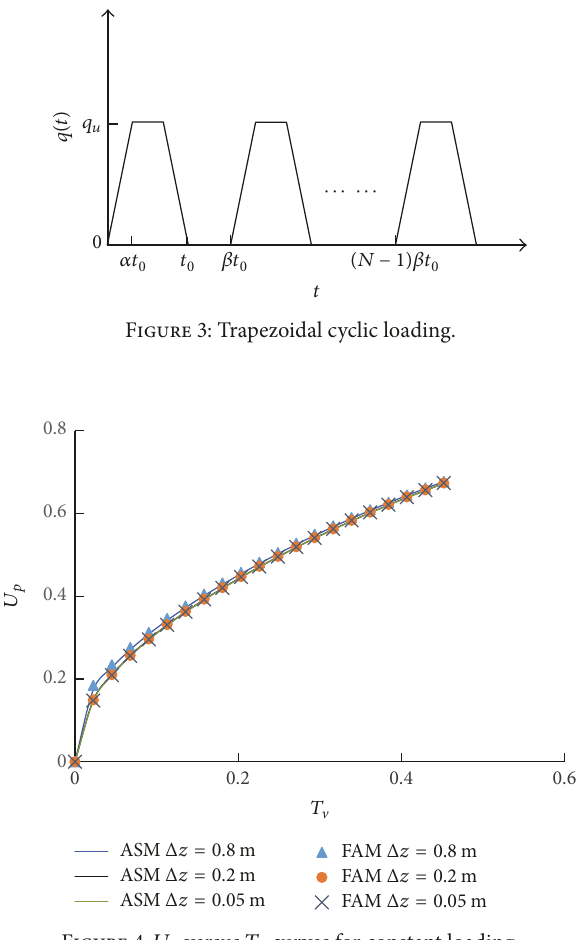
Figure 4: 𝑈 𝑝 versus 𝑇 V curves for constant loading.